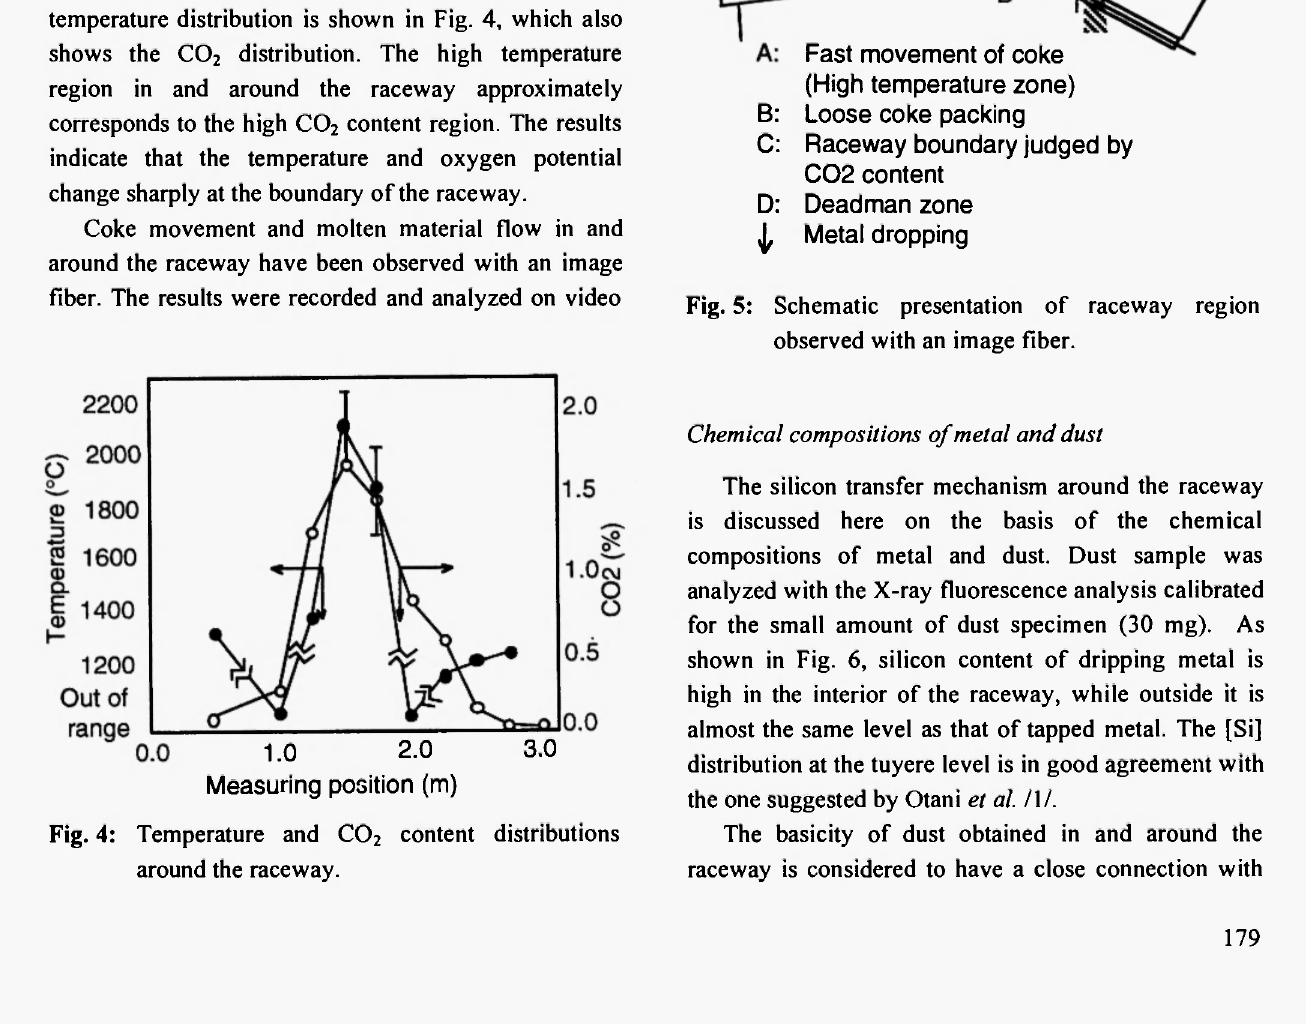
Fig. 4: Temperature and C0 2 content distributions around the raceway.